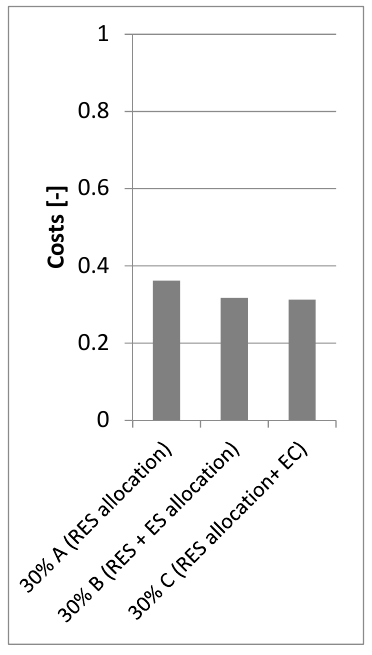
Figure 7. Costs for main scenarios—1.